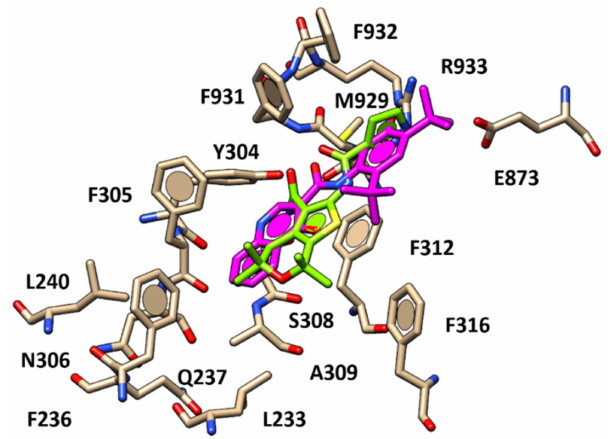
Figure 4. Docking positioning of compound 11 ( C atom; green) within the X-ray crystallographic structure of the human CFTR in complex with VX-770 ( C atom;